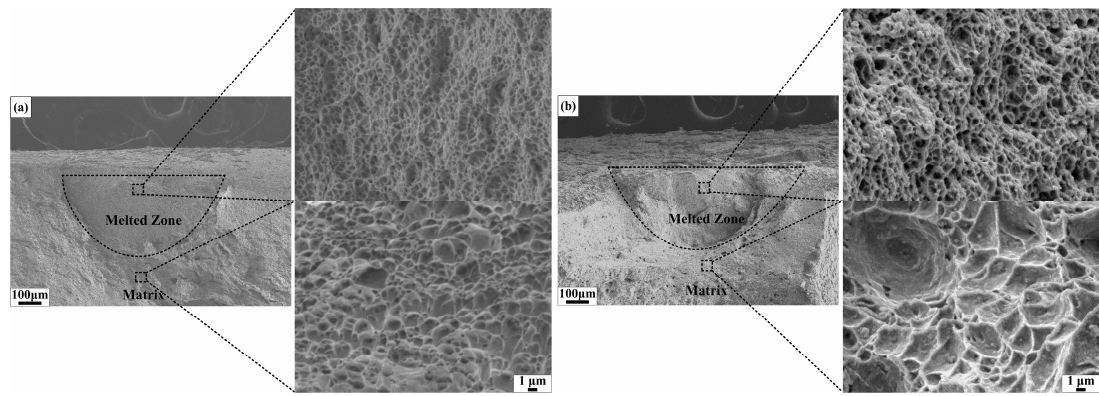
Figure 14. Fracture morphologies of LSM-treated specimen after 1200 thermal cycles: ( a ) RT and ( b ) 650 °C.